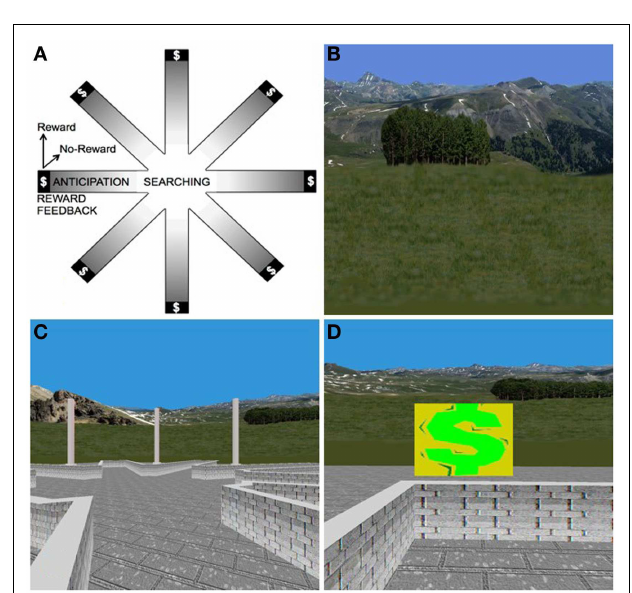
FIGURE 3 | Maps of group differences in morphological measures of the cerebral surface [reproduced from Marsh et al. (2013a)] .The signed euclidean distances between points on the surfaces of the cortex for each participant and corresponding points on a template brain were compared statistically between the BN and control groups using linear regression at each voxel on the surface while covarying for age. BN group brains were significantly reduced bilaterally in medial frontal and precentral gyri, in